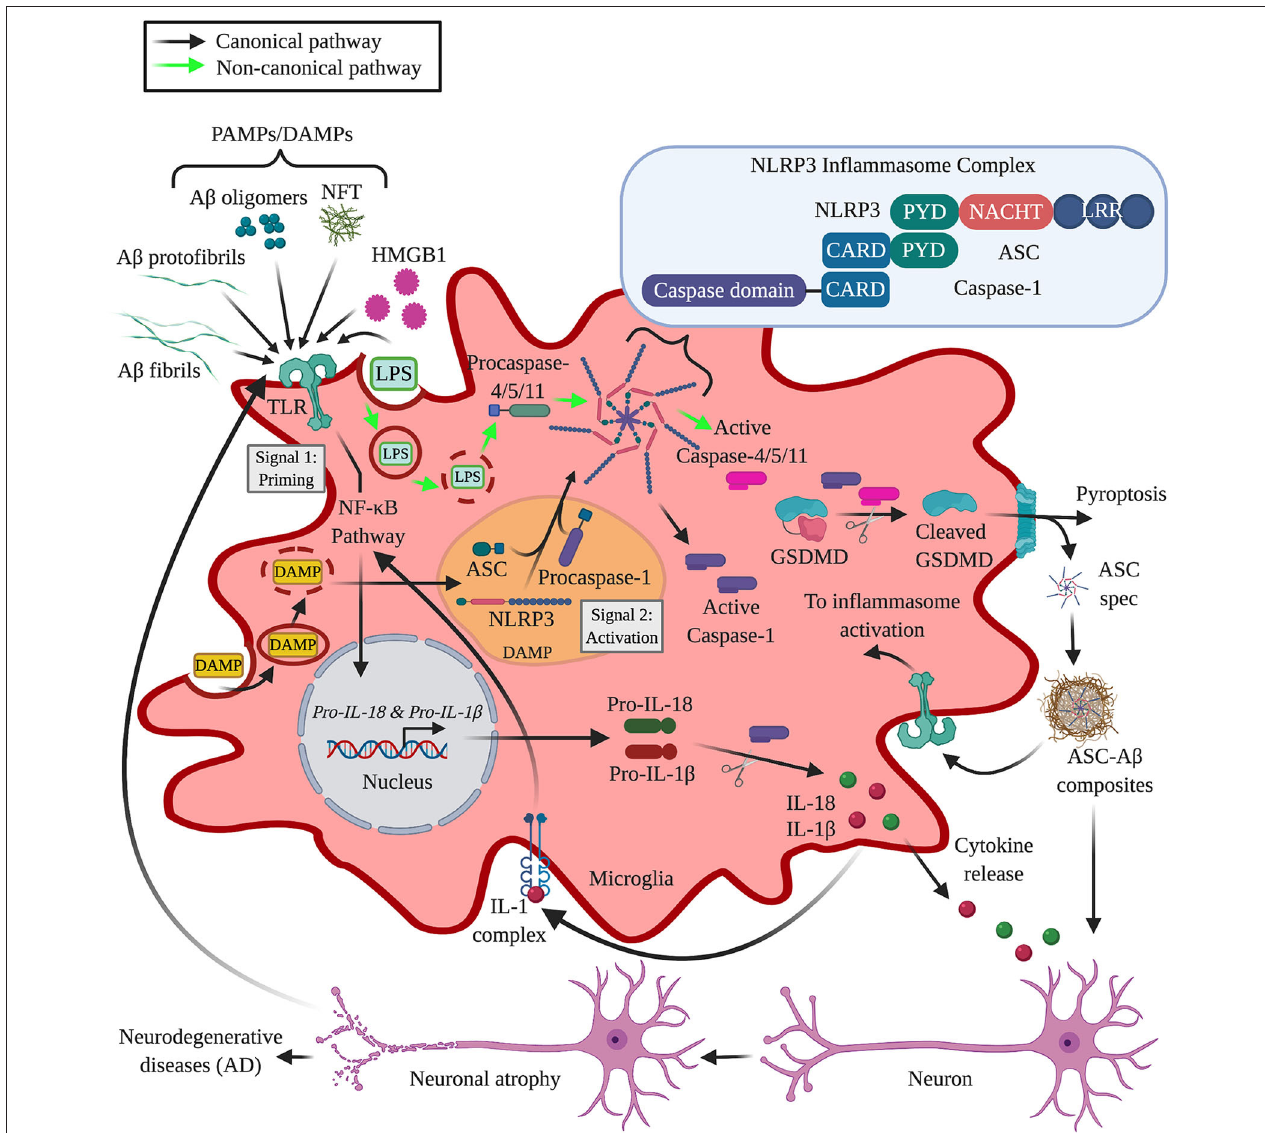
FIGURE 1 | Role of microglia and canonical NLRP3 inflammasome in Alzheimer’s disease. Cytokines, pathogen-associated molecular patterns (PAMPs), or danger-associated molecular patterns (DAMPs) bind cell surface receptors [e.g., toll-like receptors (TLRs)] on the microglia, leading to activation of the nuclear factor- κ B (NF- κ B) pathway (signal 1). The activation of the NF- κ B pathway promotes a signaling cascade, resulting in the expression of cytokines such as pro-IL-1 β and pro-IL-18 as well as NLR family pyrin domain containing 3 protein (Nlrp3). Through the canonical activation pathway, Nlrp3 oligomerizes in response to an internalized, cytosolic danger signal (DAMP) (signal 2) then recruits Asc and procaspase-1, resulting in inflammasome assembly (Asc-spec assembly) and caspase-1 autoactivation. Activated caspase-1 then cleaves pro-IL-1 β or pro-IL-18 and gasdermin (GSDMD). GSDMD cleavage is also induced by caspases 4/5/11 through a non-canonical activation pathway that detects internalized, cytosolic LPS, and other PAMPs/DAMPs that bypass membrane-bound pattern recognition receptors such as TLRs. Subsequently, GSDMD induces pyroptosis, presumably releasing Asc-specs that cross-seed extracellular amyloid beta (A β ) plaques and creates Asc-A β composites that induce a feed-forward cycle amplifying the proinflammatory response. In turn, proinflammatory cytokines including IL-1 β and IL-18 induce neuronal damage and death, causing neurodegeneration. Degraded neurons can then trigger a feedback loop by activating microglia. IL-1R complexes are also activated, creating a positive feedback loop that drives additional pro-IL-1 β production and primes local microglia for inflammasome activation. AD, Alzheimer’s disease; IL, interleukin; NFT, neurofibrillary tangles; ASC, apoptosis-associated spec-like protein containing a CARD; CARD, caspase-activation and recruitment domain; LRR, leucine-rich repeat; NACHT, nucleotide-binding oligomerization domain; PYD, Pyrin domain; HMGB1, high mobility group box 1; LPS, lipopolysaccharide; NF- κ B, nuclear factor kappa light chain enhancer of activated B cells created with